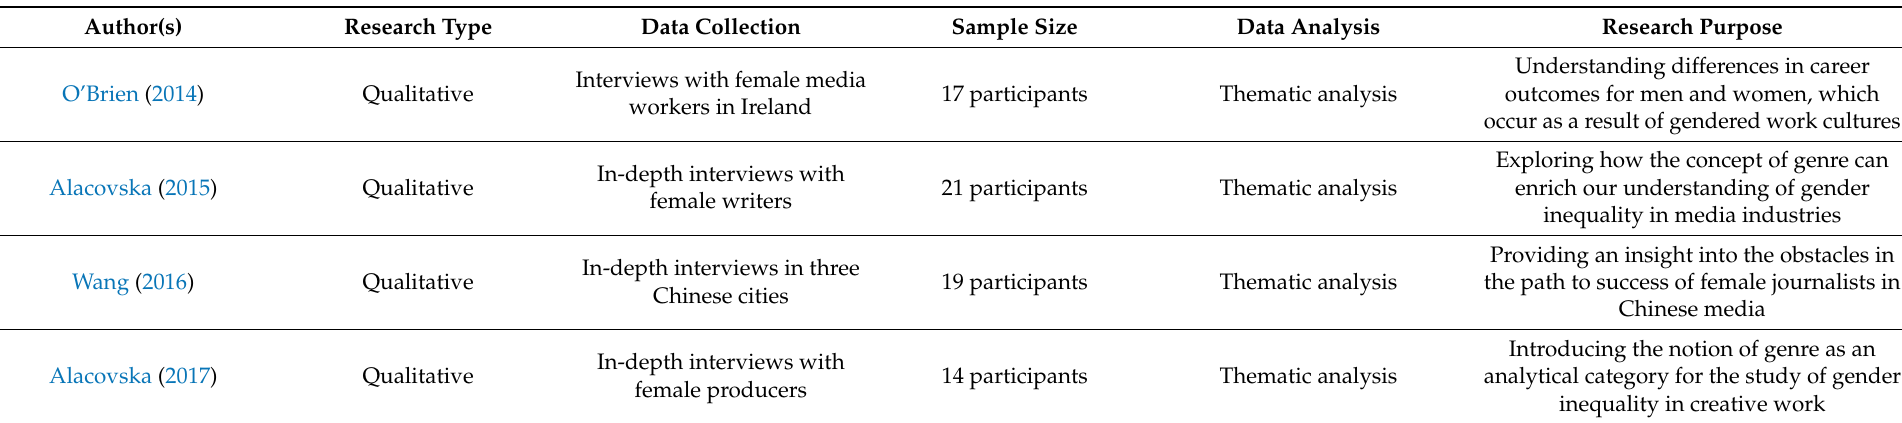
Table 6. Distribution of papers reviewed in the subtheme “gendered